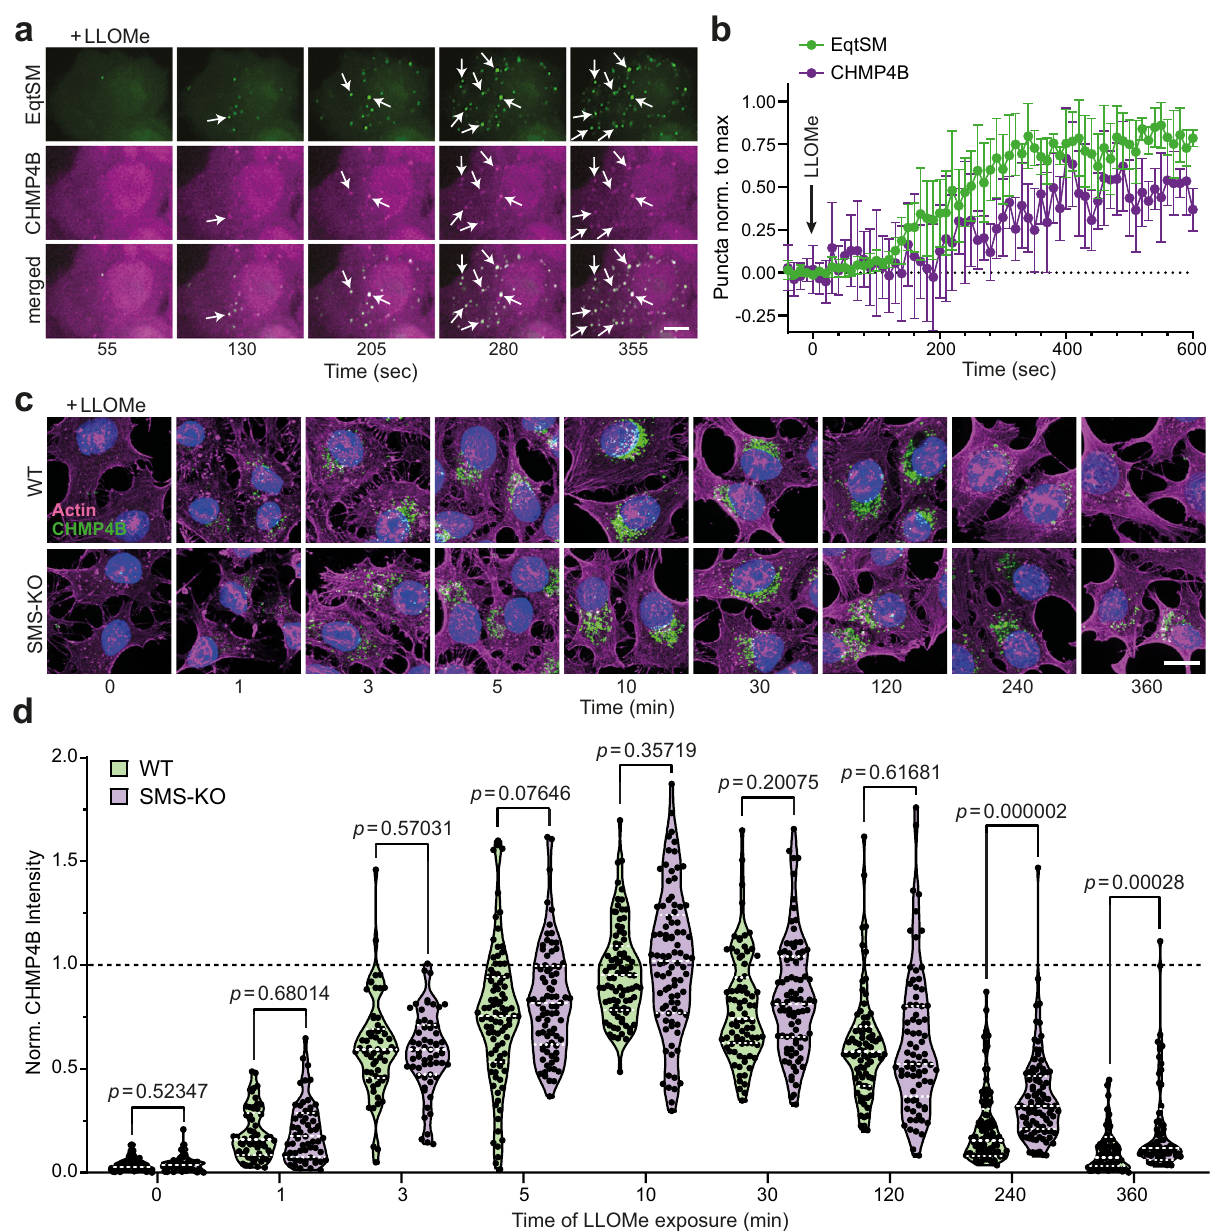
Fig. 5 SM is dispensable for ESCRT recruitment to damaged lysosomes. a Time-lapse images of HeLa cells co-expressing mKate-tagged EqtSM ( green ) and eGFP-tagged CHMP4B ( magenta ) and treated with 1 mM LLOMe for the indicated time. White arrows mark EqtSM-positive puncta that gradually accumulate CHMP4B. Scale bar, 5 μ m. b Time-course plotting EqtSM- and CHMP4B-positive puncta normalized to maximum in cells treated as in ( a ). Data are means ± SD. n = 5 cells. c Fluorescence images of wild-type (WT) and SMS-KO HeLa cells treated with 1 mM LLOMe for the indicated time, fi xed and then stained with DAPI (blue) and antibodies against CHMP4B (green) and actin (magenta). Scale bar, 10 μ m. d Time-course plotting normalized CHMP4B intensity in cells treated as in ( c ). For each violin plot, the middle line denotes the median, and the top and bottom lines indicate the 75th and 25th percentile. In chronological order: n = 40 (WT), 40 (SMS-KO), 60 (WT), 60 (SMS-KO), 60 (WT), 60 (SMS-KO), 92 (WT), 70 (SMS-KO), 80 (WT), 79 (SMS-KO), 81 (WT), 87 (SMS-KO), 82 (WT), 78 (SMS-KO), 96 (WT), 101 (SMS-KO), 70 (WT) and 70 cells (SMS-KO) over two independent experiments. P values were calculated by unpaired two-tailed t